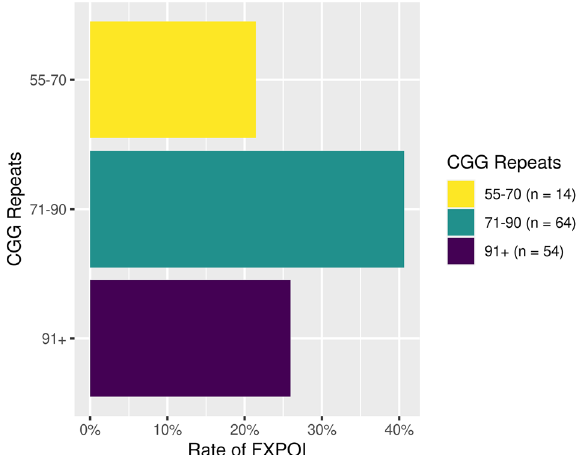
Figure 4. Association between rate of FXPOI and CGG repeat